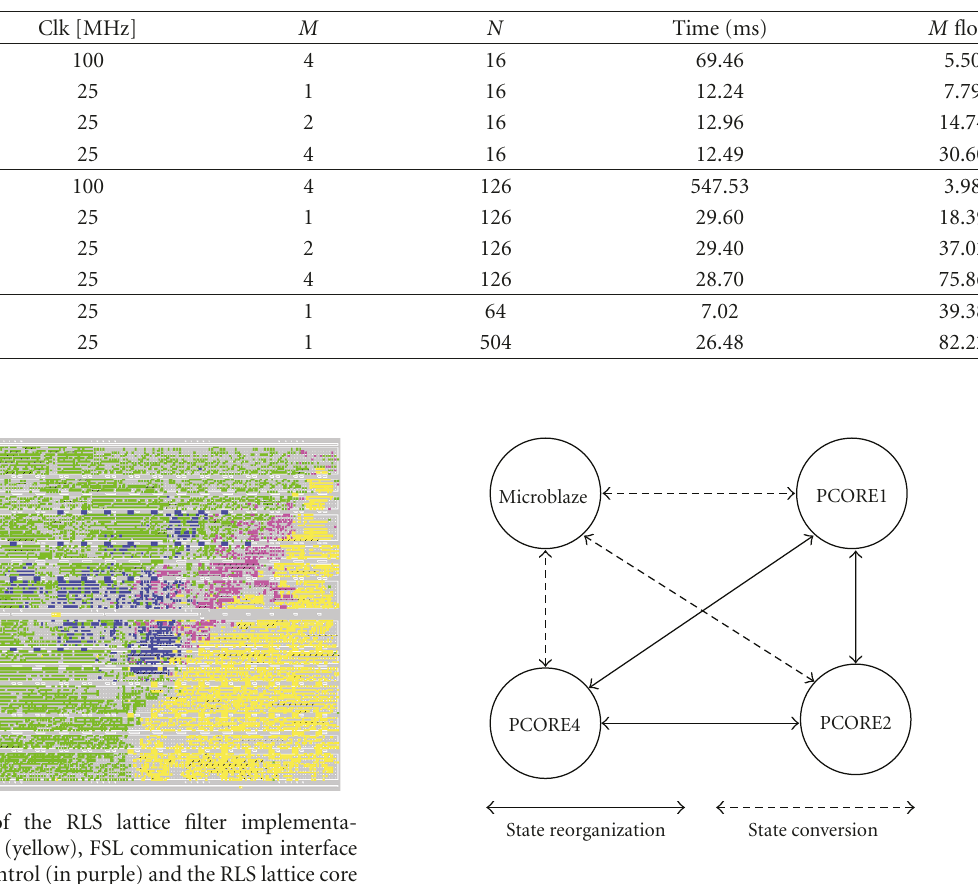
order of 126 are presented. It can be seen that the maximal filter order exploits the best RLS lattice core optimization